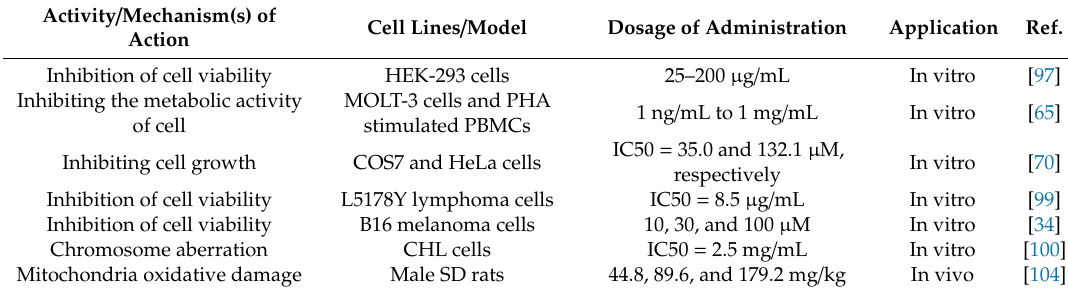
Table 3. Toxicity of